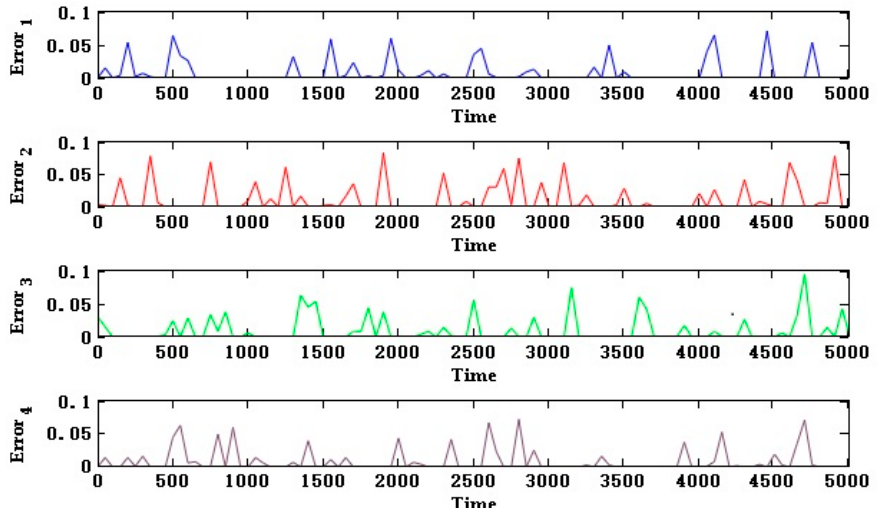
Figure 5. Simulation of bit error rate under different bit stream rates, transmission symbols and signal to noise ratio.